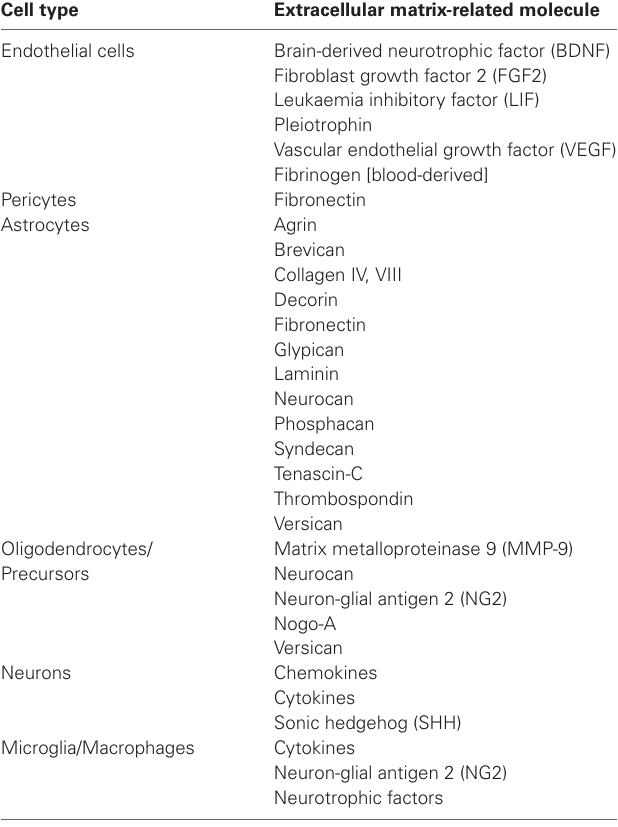
Table 1 | Important sources of extracellular signaling molecules after CNS lesion